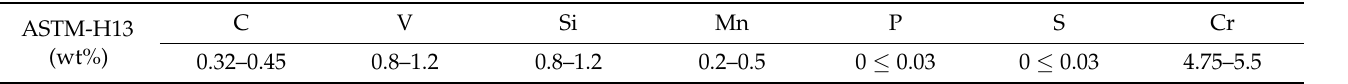
Table 2. Chemical composition of